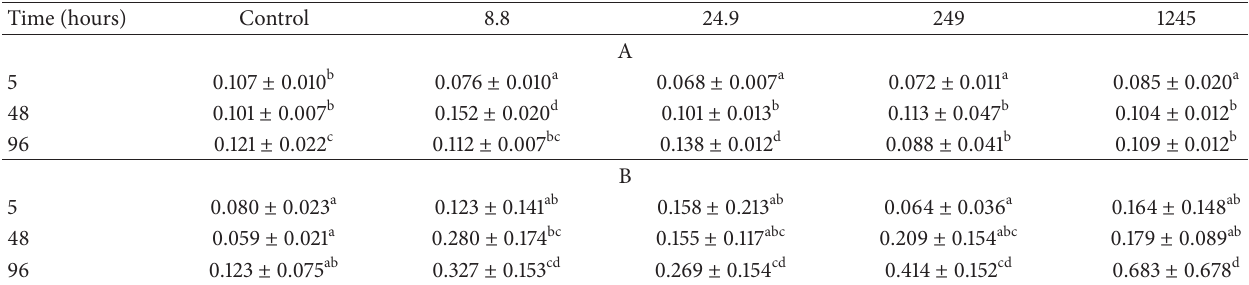
Table 4: Mean values ( ± SD) of phenoloxidase activity (A), as PO units mg protein − 1 , and of phenoloxidase activity to hemocyte concentration ratios (B) in L. vannamei , exposed to four concentrations ( 𝜇 gL − 1 ) of